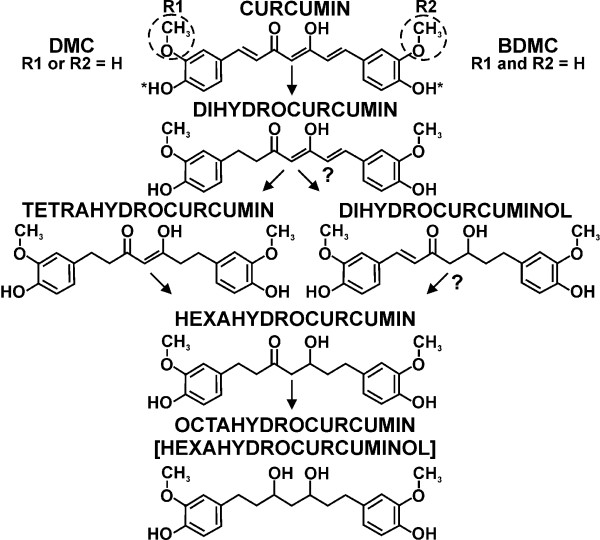
Structure of curcuminoids and putative alternative reduction pathways.